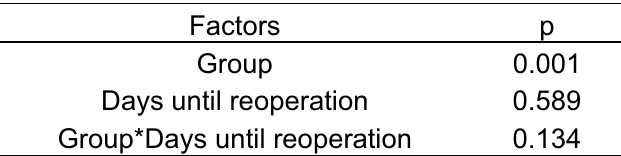
TABLE 5 – Two-factor ANOVA for the comparison of the time spent on wound